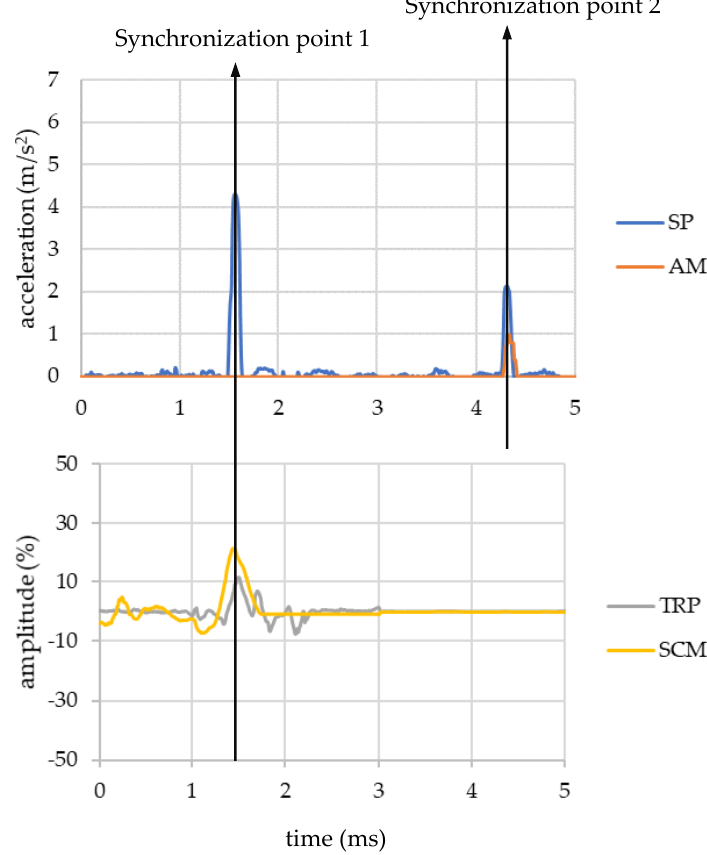
Figure 6. Synchronisation timing of the signals employing the two synchronisation points.